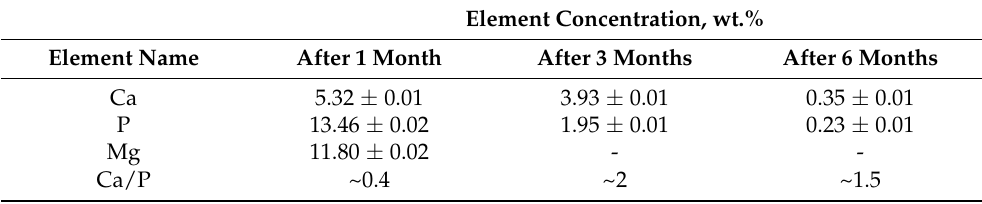
Table 2. The chemical compositions of the bones near the implant sites. Element Concentration,